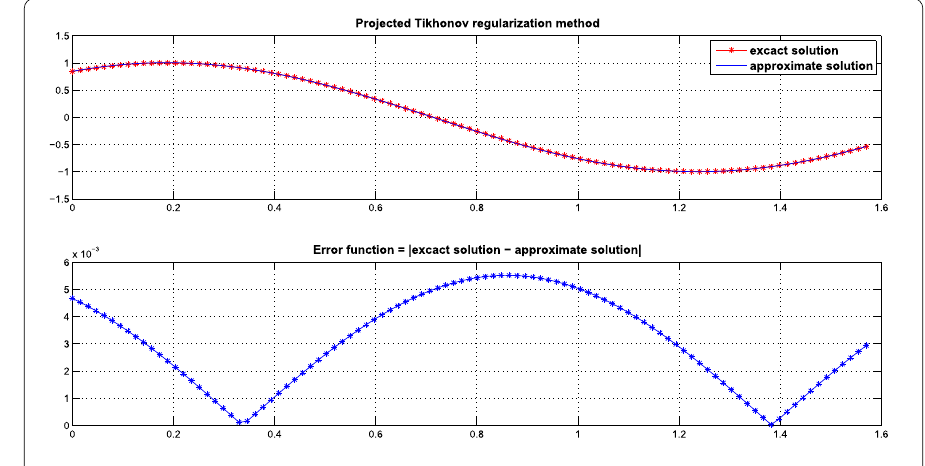
Figure 8 Example 2, noise level = 1/100, n =